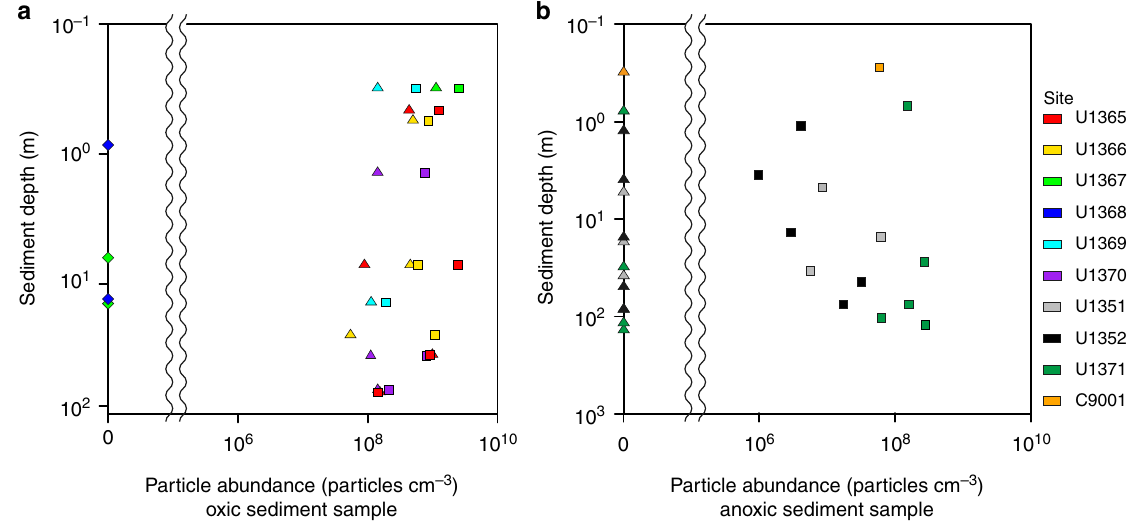
Fig. 3 Number of microparticles in sediment samples. a Depth pro fi les of numbers of Mn-microparticles in pelagic oxic sediment samples from the South Paci fi c Gyre. b Depth pro fi les of numbers of clay microparticles in anoxic sediment samples from the South Paci fi c and continental margin. In a and b , colored triangles indicate Mn-microparticles, colored squares denote clay-microparticles, and colored diamonds indicate calcareous ooze samples without